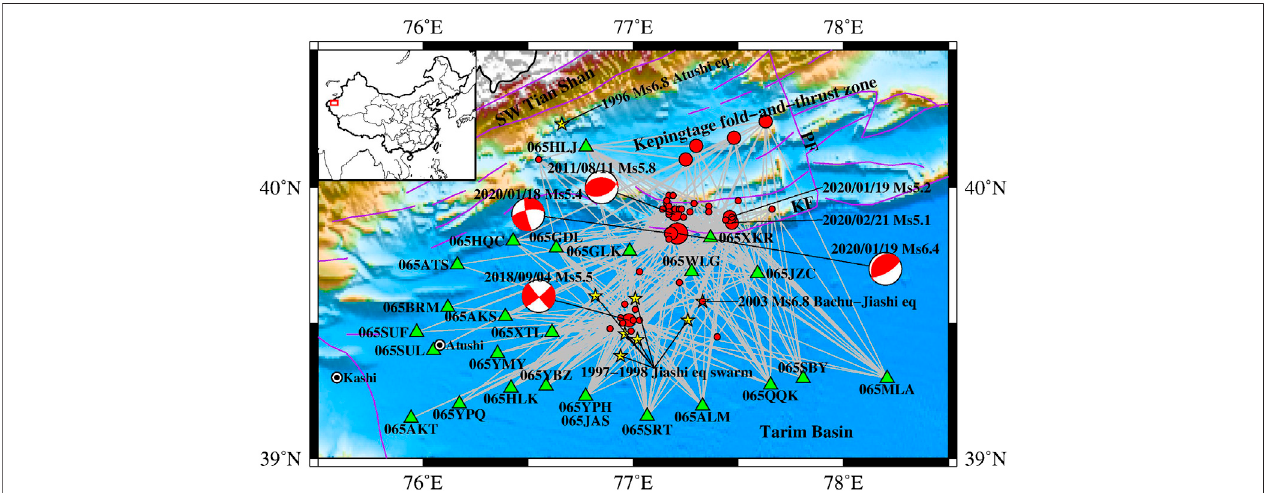
FIGURE 1 | Locations of earthquakes (circles) and stations (triangles) considered in the spectral inversion analysis. The stars represent the major historical earthquakes in the proximity of the seismogenic area. The ray paths from the epicenter to the station are depicted by the gray lines. The focal mechanisms were derived from the United States Geology Survey. Purple lines indicate the active faults, and KF and PF represent the Kepingtage thrust fault and the Piqiang fault, respectively. Insert in the top left corner shows the location of the study region (rectangle).